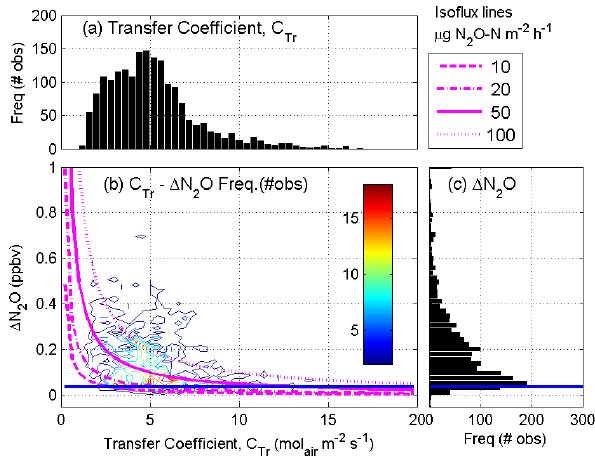
Fig. 6. Observation frequencies of 1 N 2 O and C Tr : separate his- tograms and combined contour plot. (a) Histogram of observations of the transfer coefficients, C Tr . (b) Contour plot showing frequency of observations in C Tr – 1 N 2 O space. The colours of the contour lines represent number of observations at each combination of C Tr and 1 N 2 O, and is proportional to the cumulative flux. (c) His- togram of 1 N 2 O observations (same vertical scale as b ). The ma- genta lines are isoflux lines (i.e. contours of equal flux in units of µgN 2 O–Nm − 2 h − 1 ) showing particular combinations of C Tr and 1 N 2 O that result in the fluxes corresponding to the legend in the top right panel. The horizontal blue line indicates the minimum re- solvable 1 N 2 O, referred to in the text as 1 N 2 O MinRes (equal to 0.039ppb).